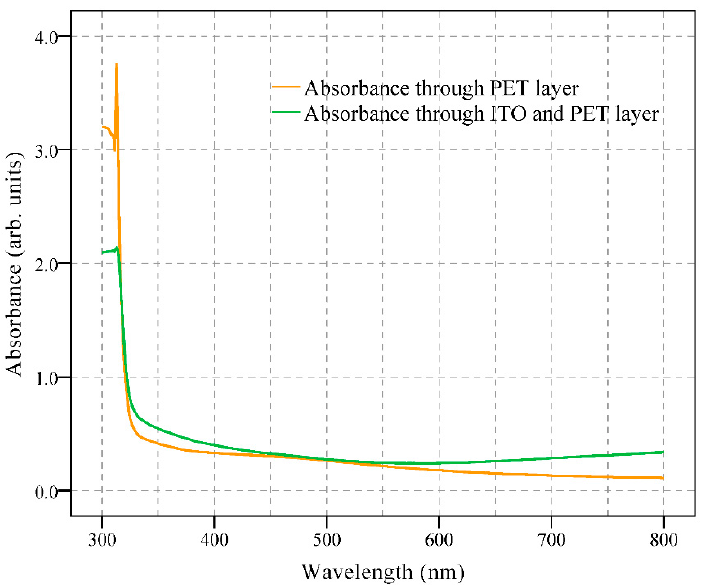
Figure 7. UV–VIS measurement of the PET substrate after laser ablation and ITO-covered PET sub- strate.